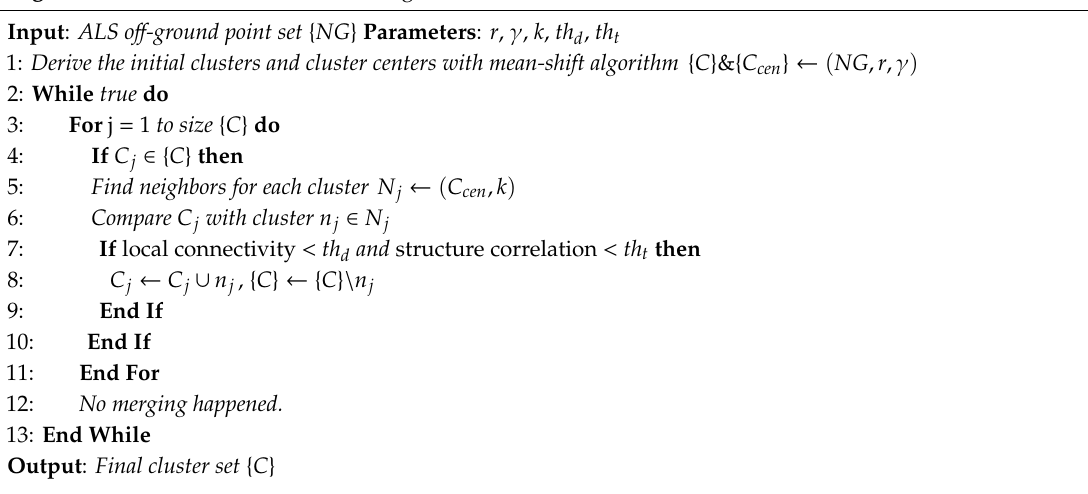
Algorithm 2. Constrained mean-shift